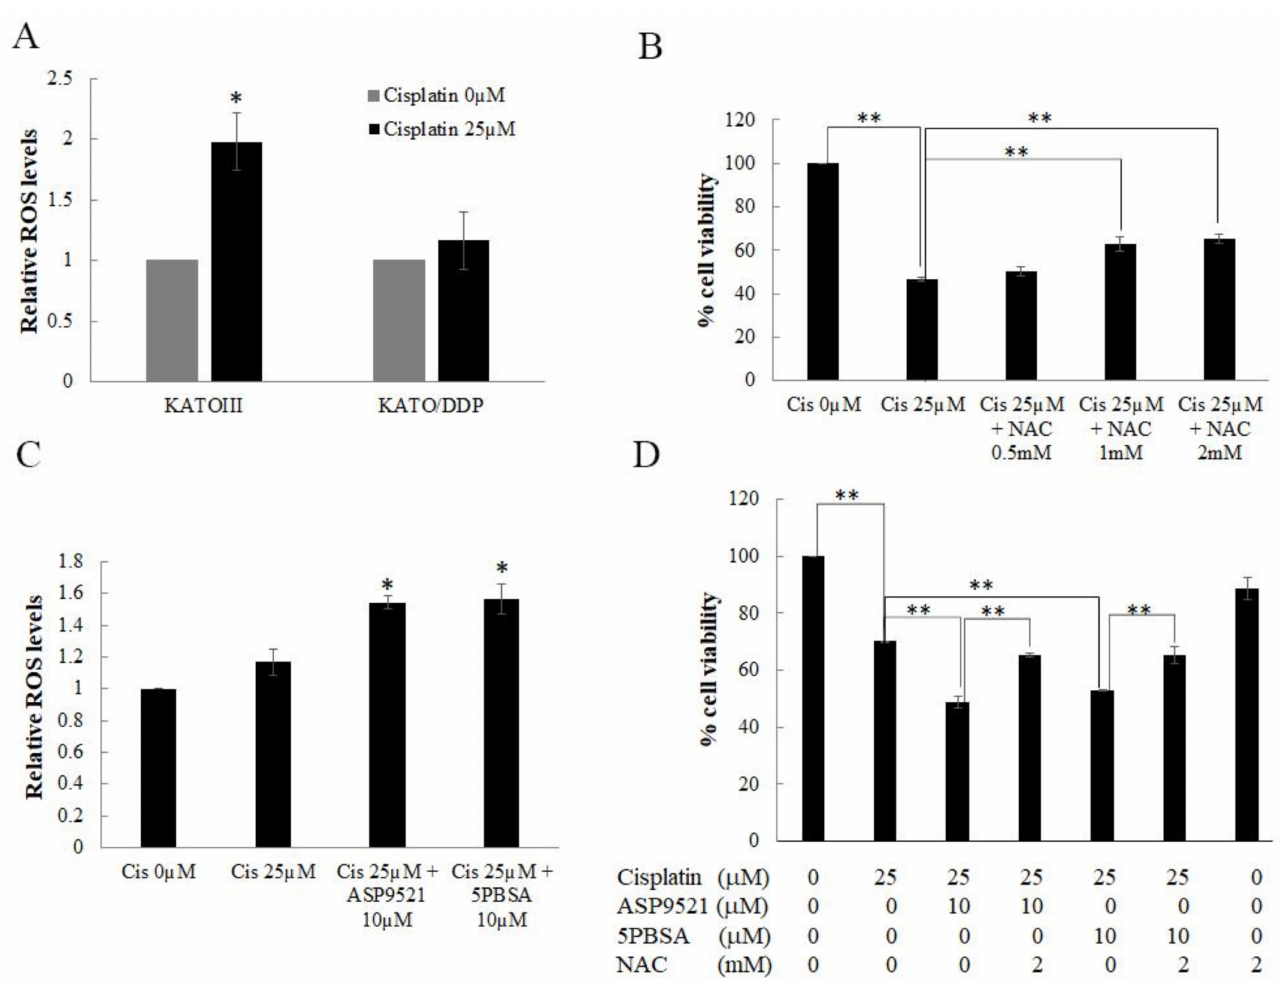
Figure 9. Role of intracellular ROS in AKR1C1 and 1C3 mediating chemo-resistance in signet ring gastric cancer cells. ( A ) Intracellular ROS level in KATOIII and KATO/DDP cell lines after 1 h treated with cisplatin was detected by DCF-DA ROS assay. ( B ) KATOIII cells were treated with cisplatin with or without NAC for 48 h at 37 ◦ C. Cell viability was assessed by using trypan blue cell exclusion assay. ( C ) Intracellular ROS level in KATO/DDP cells after treatment with cisplatin and ASP9521 or 5PBSA. KATO/DDP cells were pretreated with ASP9521 or 5PBSA at 10 µ M for 3 h and added with cisplatin at 25 µ M. Intracellular ROS was measured by DCF-DA ROS assay after 1 h of cisplatin treatment. ( D ) Cell viability of KATO/DDP cells treated with cisplatin and ASP9521 or 5PBSA with or without NAC. Data are presented as mean ± SD; * represents p < 0.05 and ** represents p <